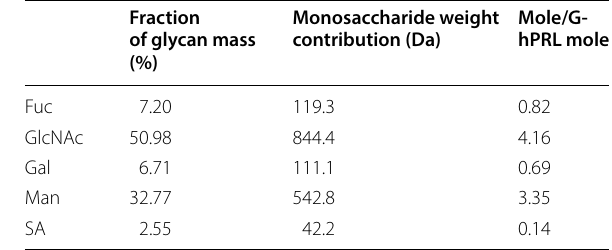
Table 4 Monosaccharide/HEK-G-hPRL molar ratio determination based on